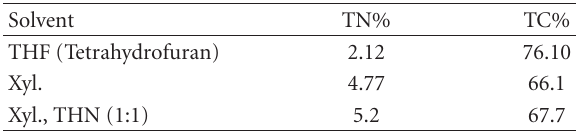
Figure 6: E ff ect of temperature on the nitrogen content after immersing 8% DVB polymer in TMA for 4